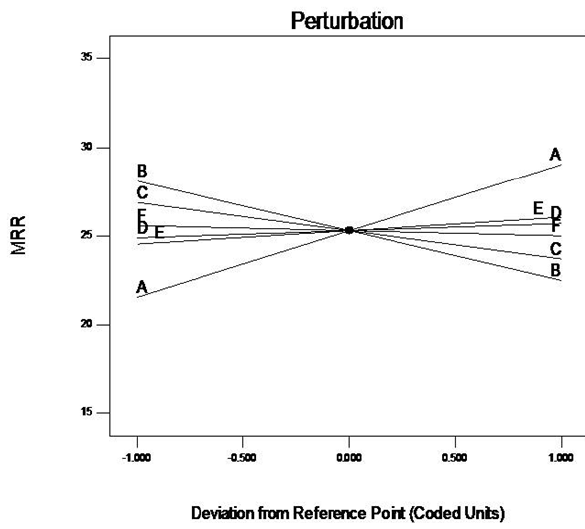
Figure 2: Perturbation plot showing the effect of individual parame- ters on